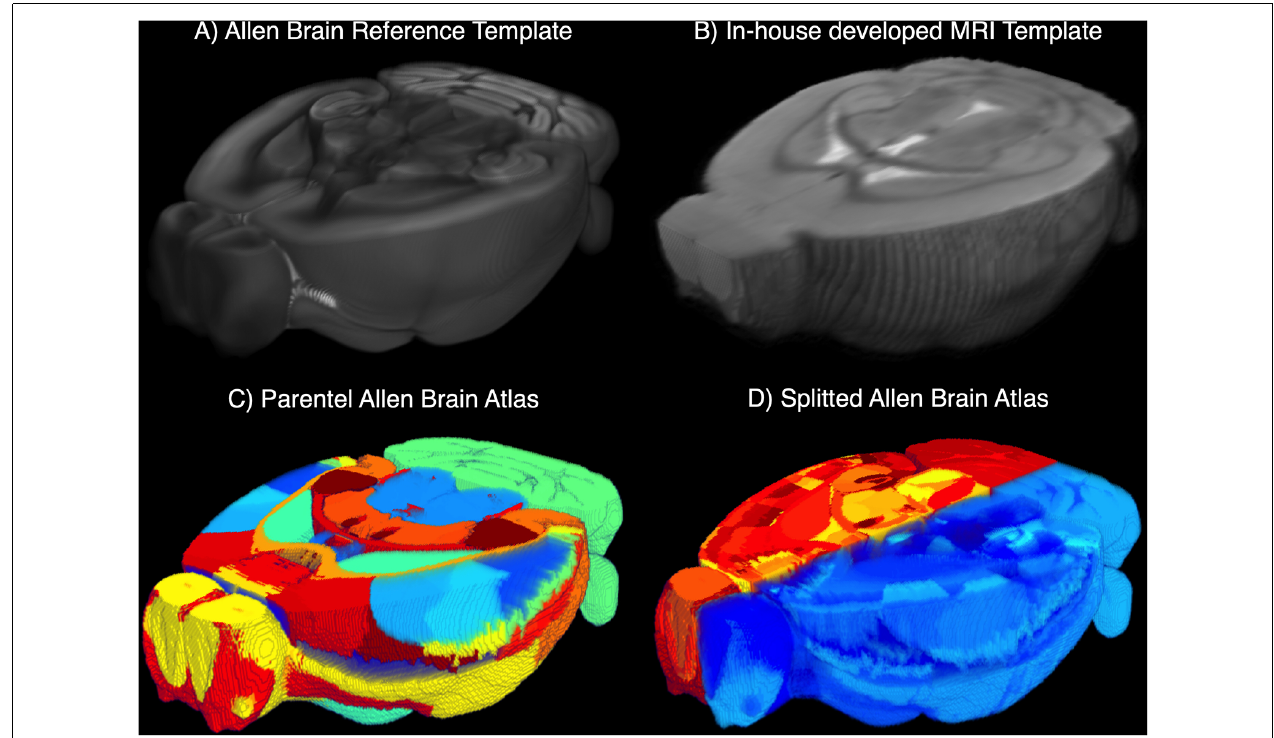
FIGURE 3 | 3D cut-outs of the (A) Allen Brain Reference Atlas (ARA) and (B) the in-house developed MRI template (MTPL). The annotations of the ARA I A ( x ) and the related ARA template (A) are overlaid with the MTPL I T ( x ) consisting of N = 30 T2w. Parental ARA labels I A ↑ ( x ) (C) and detailed ARA labels with hemisphere split (D)